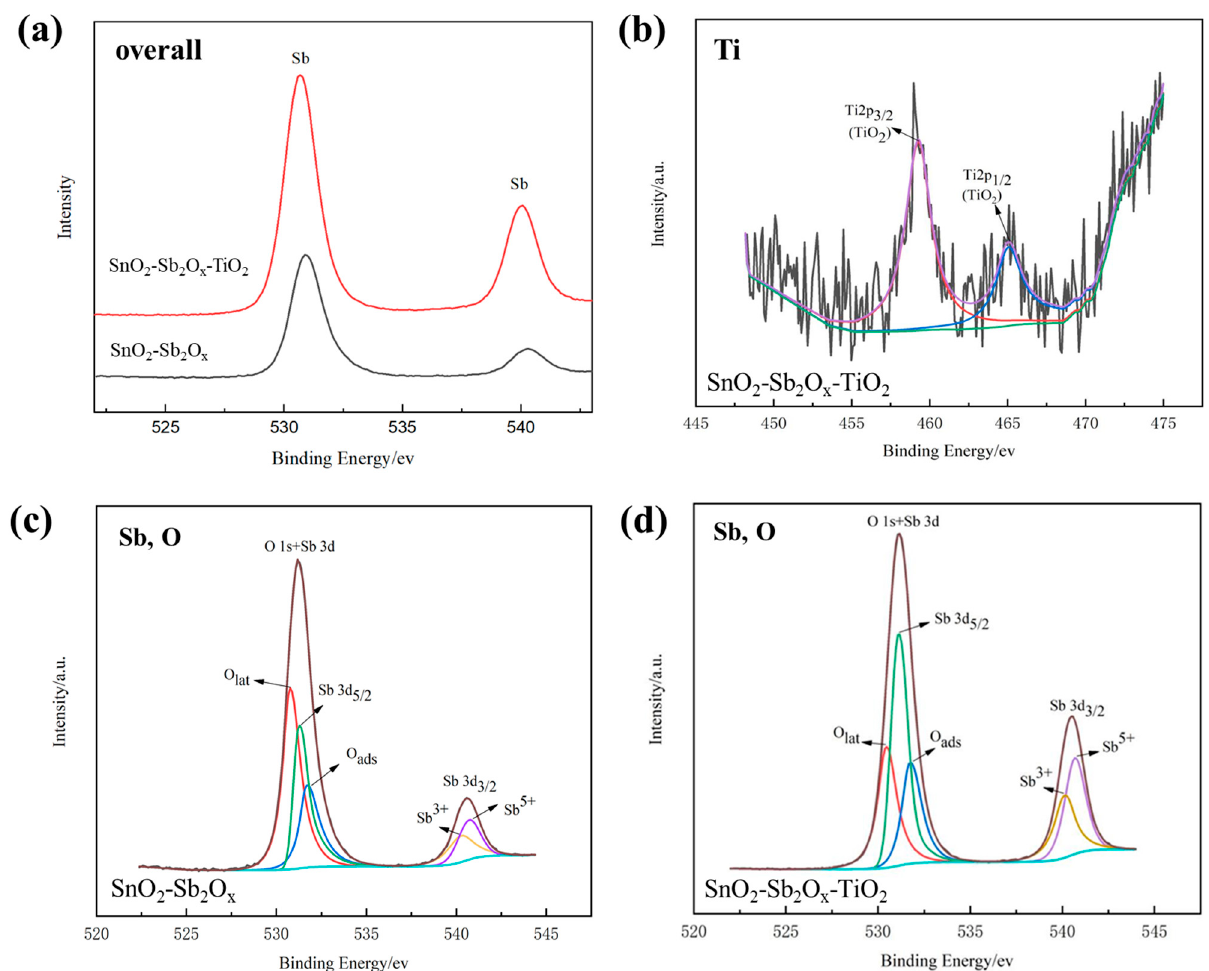
Figure 4. XPS spectra of Ti/SnO 2 -Sb 2 O x and Ti/SnO 2 -Sb 2 O x -TiO 2 (10 mL/L TiO 2 sol addition): ( a ) the overall spectra, ( b ) Ti spectra for Ti/SnO 2 -Sb 2 O x -TiO 2 , ( c ) Sb, O spectra for Ti/SnO 2 -Sb 2 O x , and ( d ) Sb, O spectra for Ti/SnO 2 -Sb 2 O x -TiO 2 .